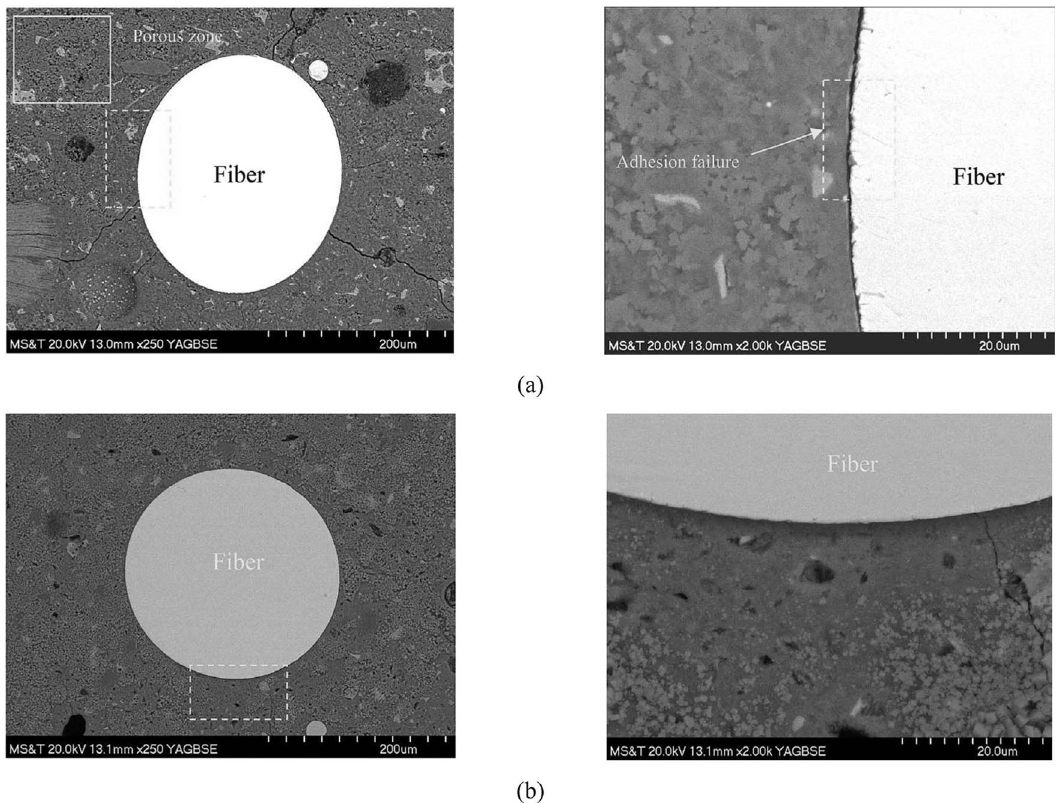
Figure 5: E ff ect of di ff erent content of nano - CaCO 3 as cement replacement on the fi ber and matrix in UHPC: ( a ) 0.0% and ( b ) 3.2% [ 59 ]